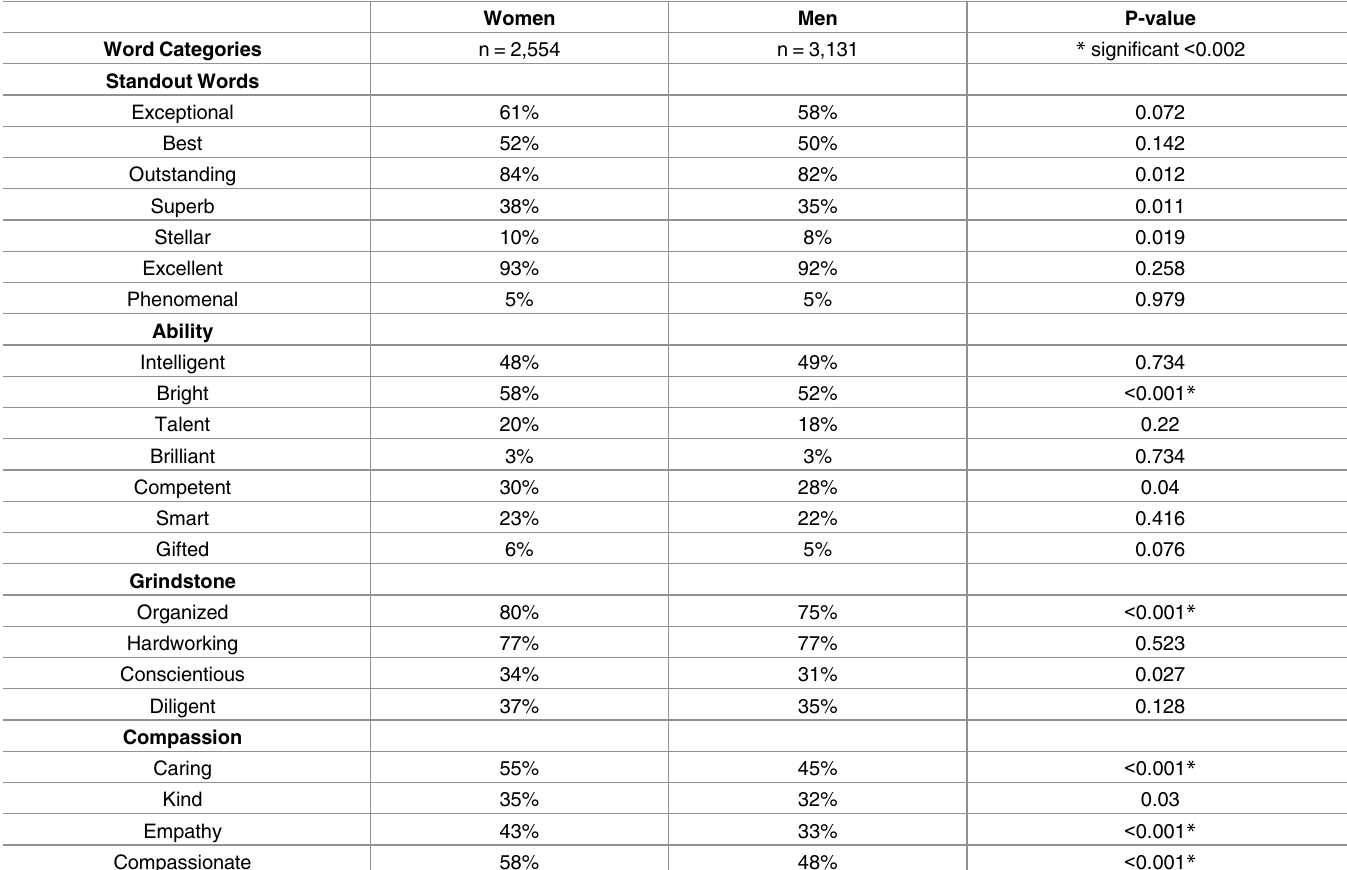
Table 6. Descriptiveword categories by